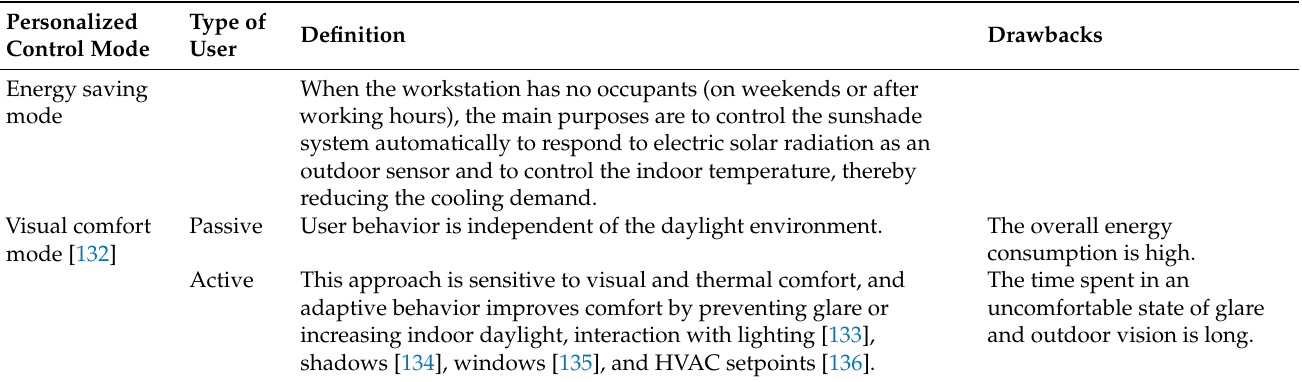
Table 6. AF control modes (adapted from ref. [116]).